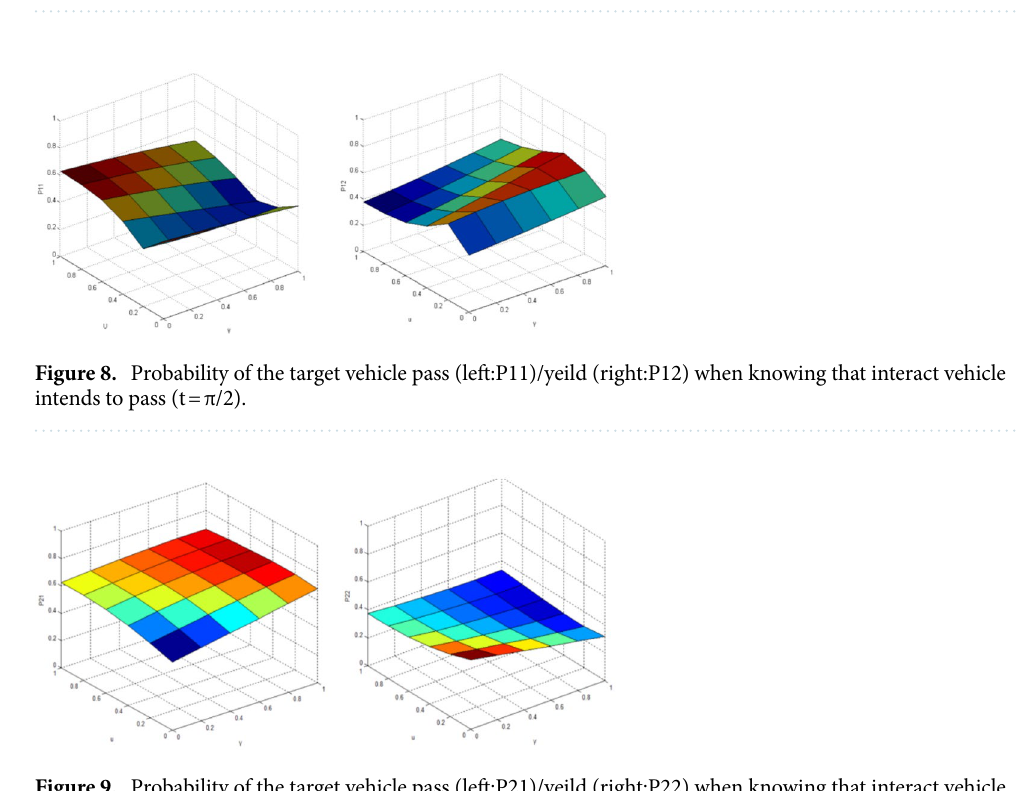
Figure 7. The learned decision weighting function (red curve).